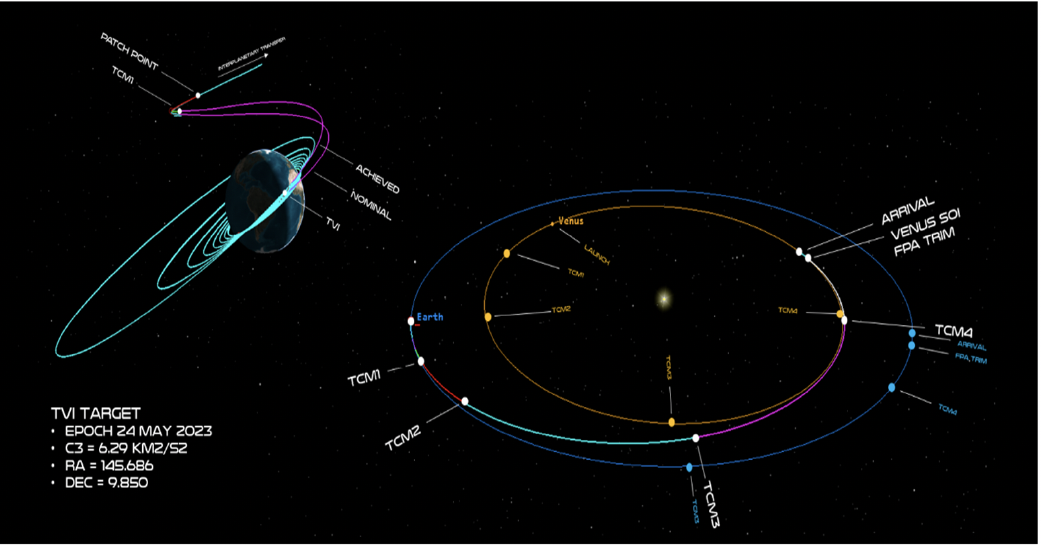
Figure 4. Phasing orbits approach to escape trajectory and typical trajectory correction maneuvers are used to target entry interface at Venus.